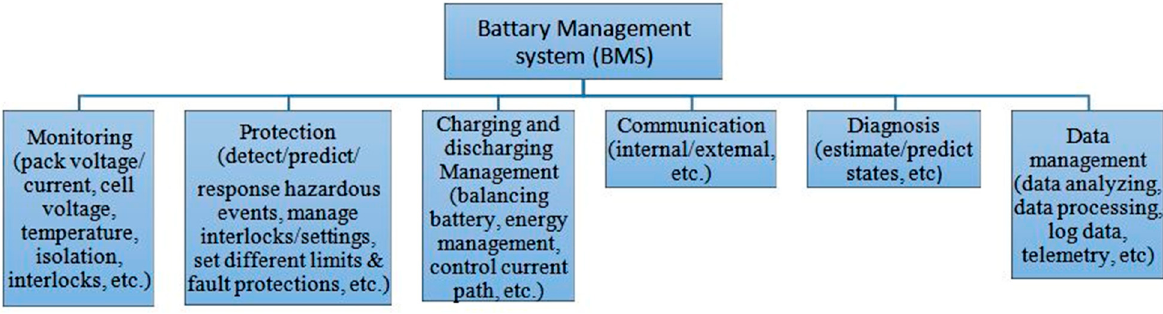
Figure 3. BMS functionalities [18].